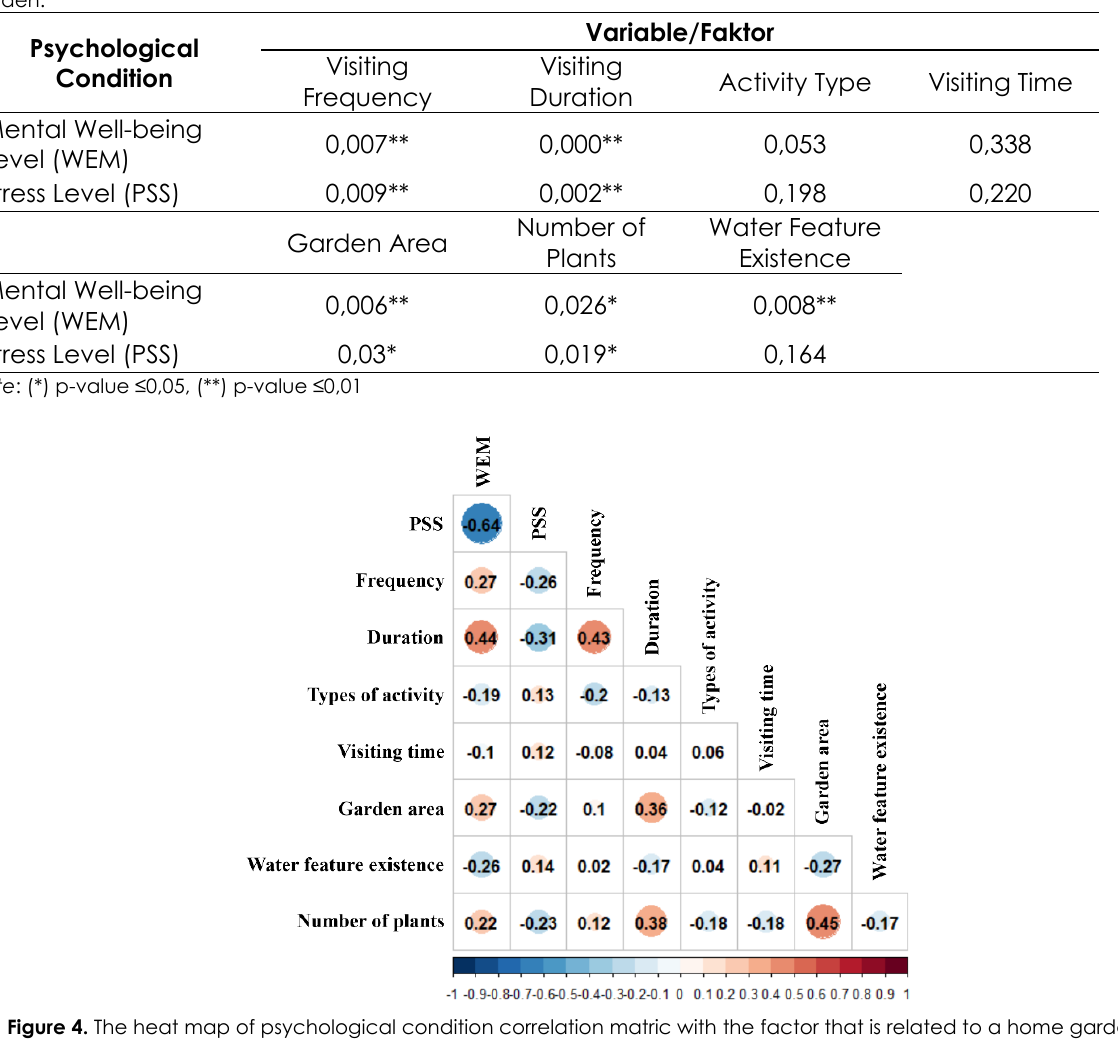
Figure 4. The heat map of psychological condition correlation matric with the factor that is related to a home garden. Note : The number close to 1 and -1 shows a strong